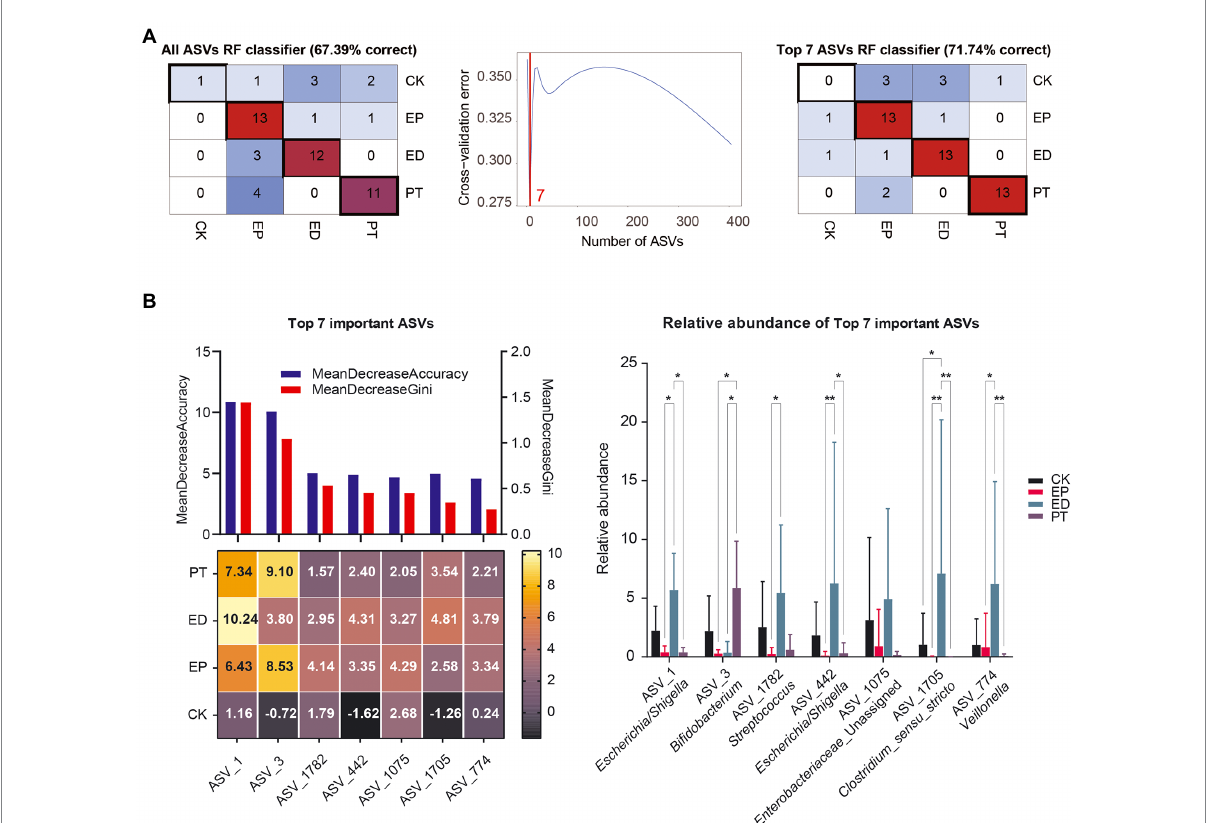
FIGURE 5 Identification of microbial markers of epilepsy and concomitant diarrhea by random forest models. (A) A 10-fold cross-validation on a random forest model was performed to detect unique amplicon sequence variant (ASV)–based markers. (B) The mean decrease accuracy, mean decrease Gini, importance, and relative abundance of the top 7